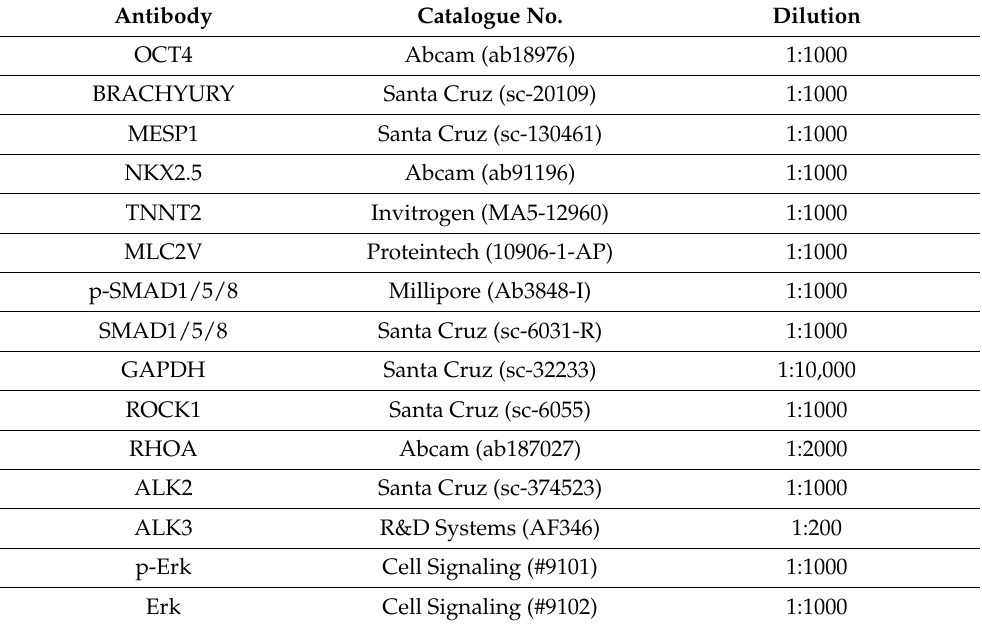
Table 1. Antibody information used in this